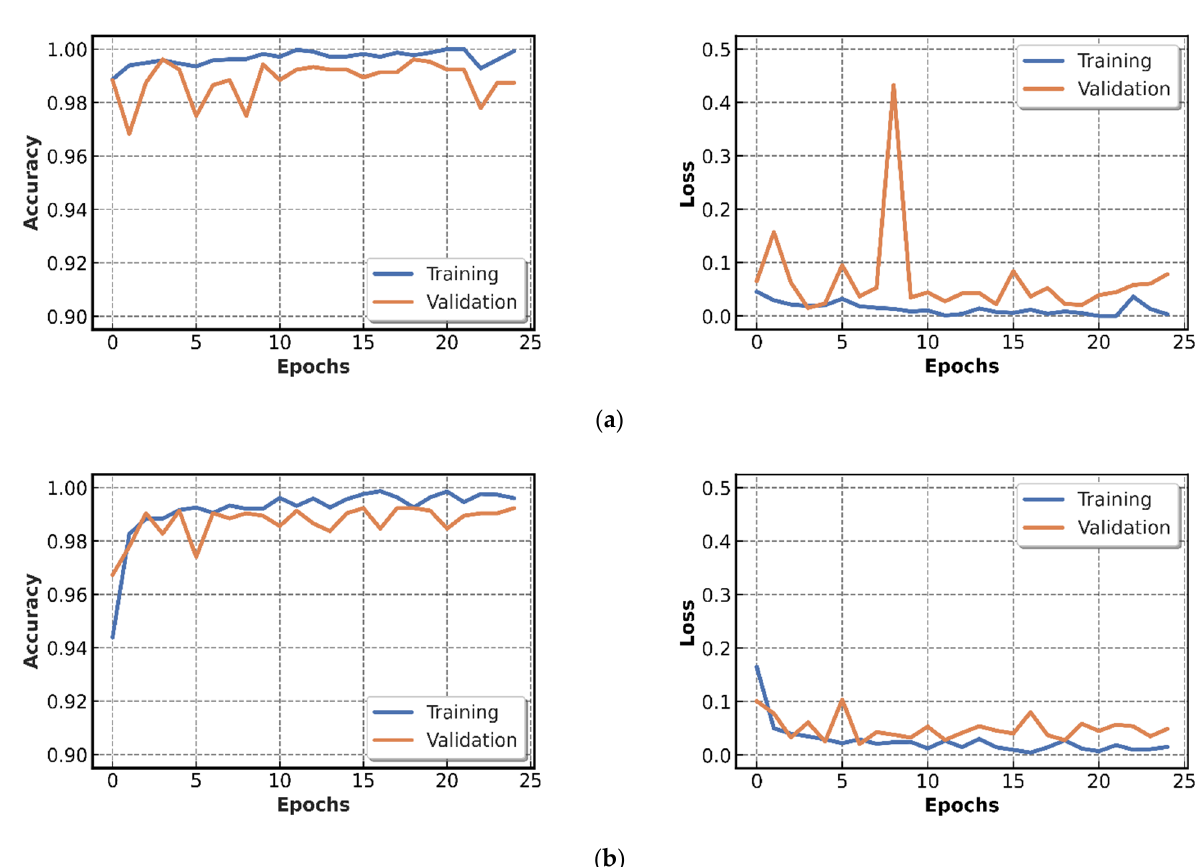
Figure 6. Accuracy and Loss curves for proposed concatenation model. ( a ) Proposed concatenation model of the modified ResNet50 V2 and MobileNet V2 models, ( b ) Proposed concatenation model of the modified Xception and Inception V3 models.